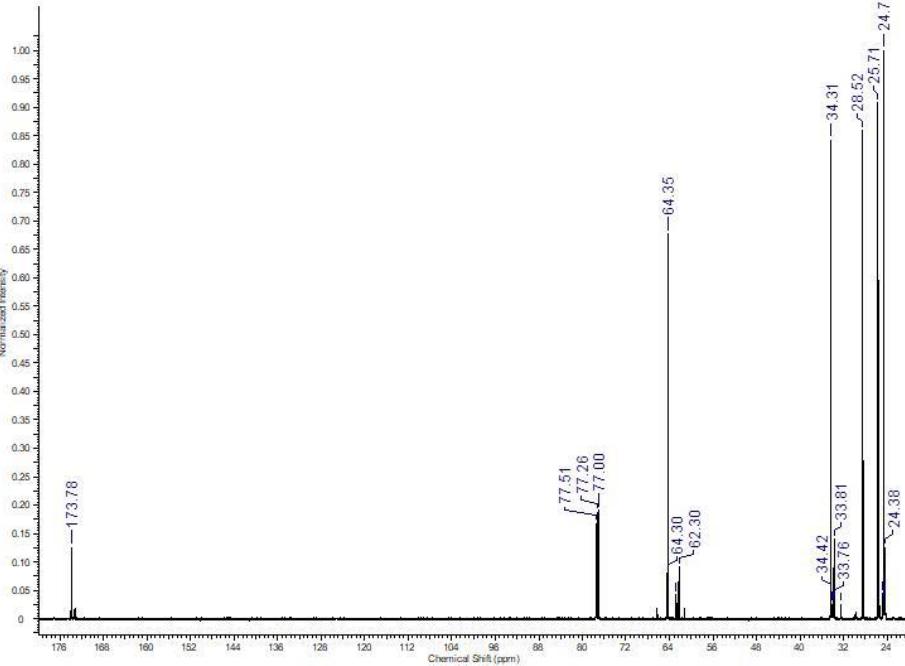
Figure 5. 1 H NMR spectrum of PCL 5000 -PEA 2500 -PCL 5000 sample in CDCl 3 .